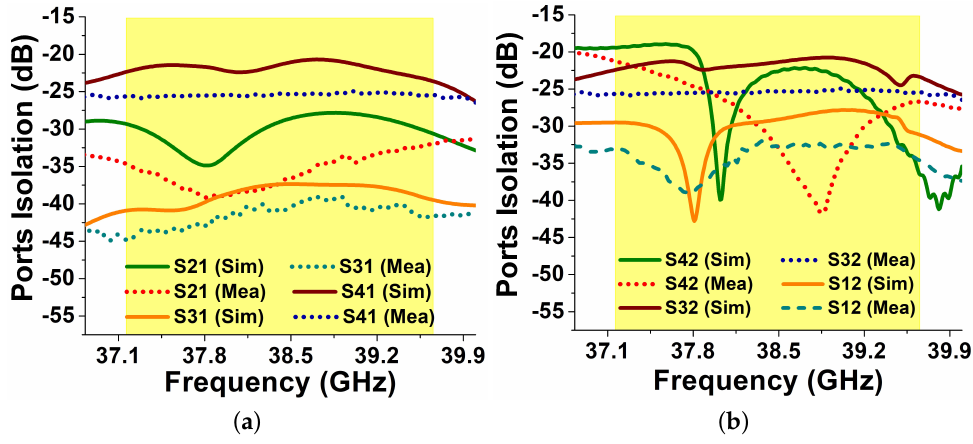
Figure 8. 4-port MIMO antenna isolation performance with respect to ( a ) P1; and( b ) supplemen- tary